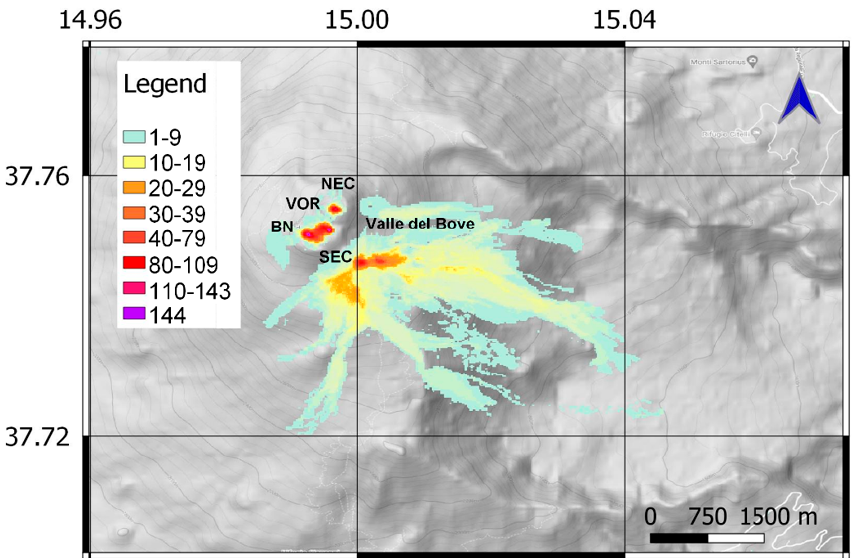
Figure 10. Map of the areas affected by thermal anomalies (number of L8-OLI and S2-MSI scenes) at Mt. Etna, generated by analysing satellite data of 2013–2021 through the NHI algorithm, under the GEE platform. Google terrain is in the background. Note the highest values (from red to purple) retrieved over summit craters and the Valle del Bove.